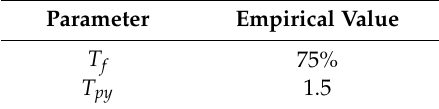
Figure 12. The flow chart of the complex structure boundary recognition. Table 2. The empirical values of parameters involved in the complex structure boundary recognition.